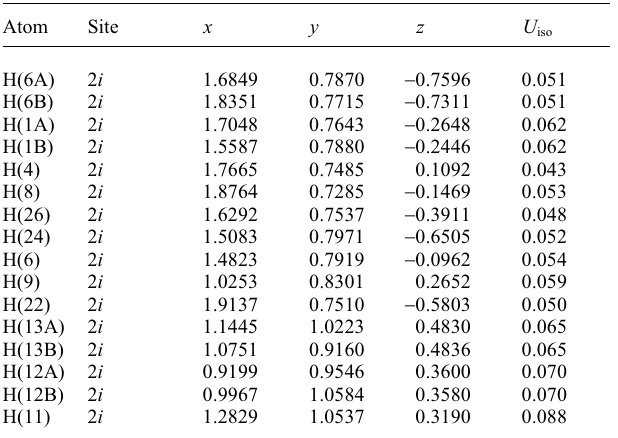
Table 2. Atomic coordinates and displacement parameters (in Å 2 )